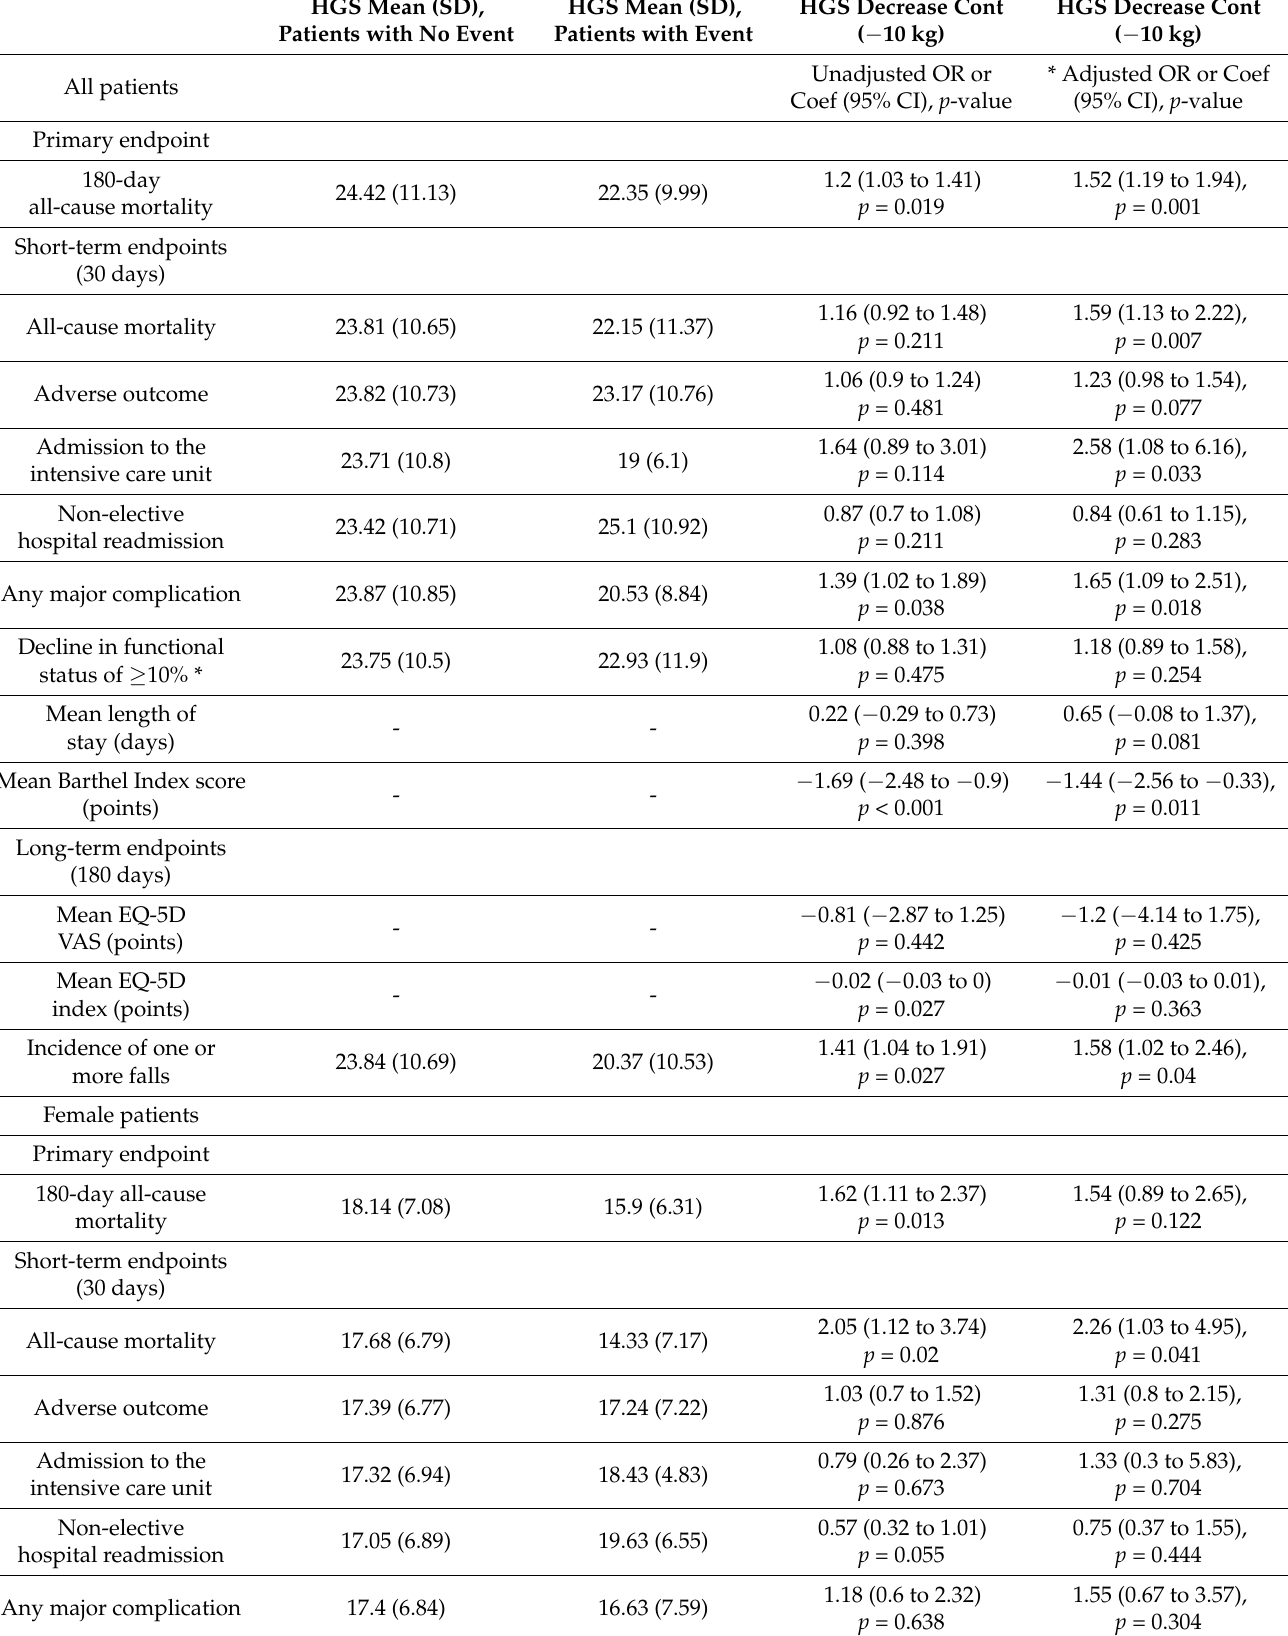
Table 3. Association of handgrip strength with short- and long-term outcomes stratified by